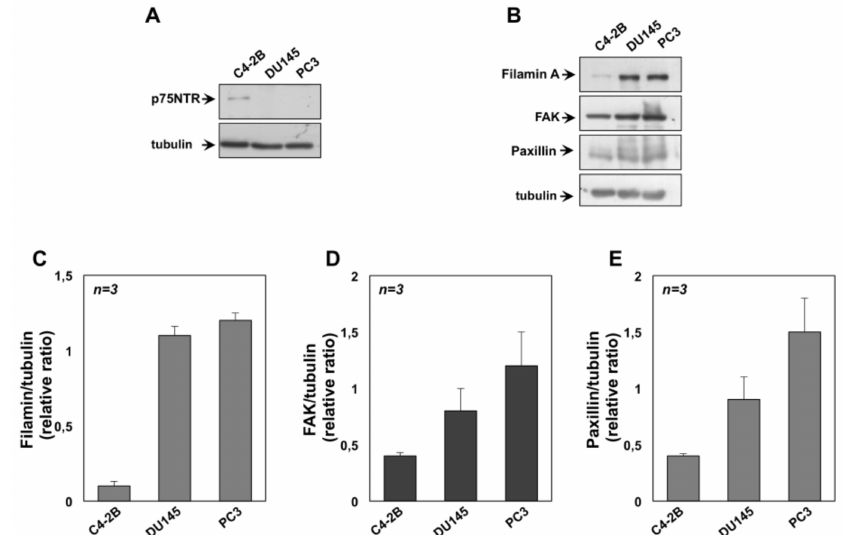
Figure 6. Expression of p75NTR and signaling e ff ectors involved in locomotion of castration-resistant prostate cancer (CRPC) cells. C4-2B, DU145 and PC3 cells were used. In A , lysates from the indicated cell lines were prepared and proteins were analyzed by western blot, using the antibodies against p75NTR. In B , lysates from the indicated cell lines were prepared and proteins were analyzed by Western blot, using the antibodies against the indicated proteins. Filters were re-probed using anti tubulin antibody, as a loading control. Western blots in A and B are representative of three di ff erent experiments. Expression levels of proteins were analyzed by densitometry analysis, using NIH Image J Software. The ratio between Filamin A / tubulin ( C ), FAK / tubulin ( D ) and Paxillin / tubulin ( E ) was evaluated. Results were expressed as relative ratio. Means and SEMs are shown, n represents the number of the